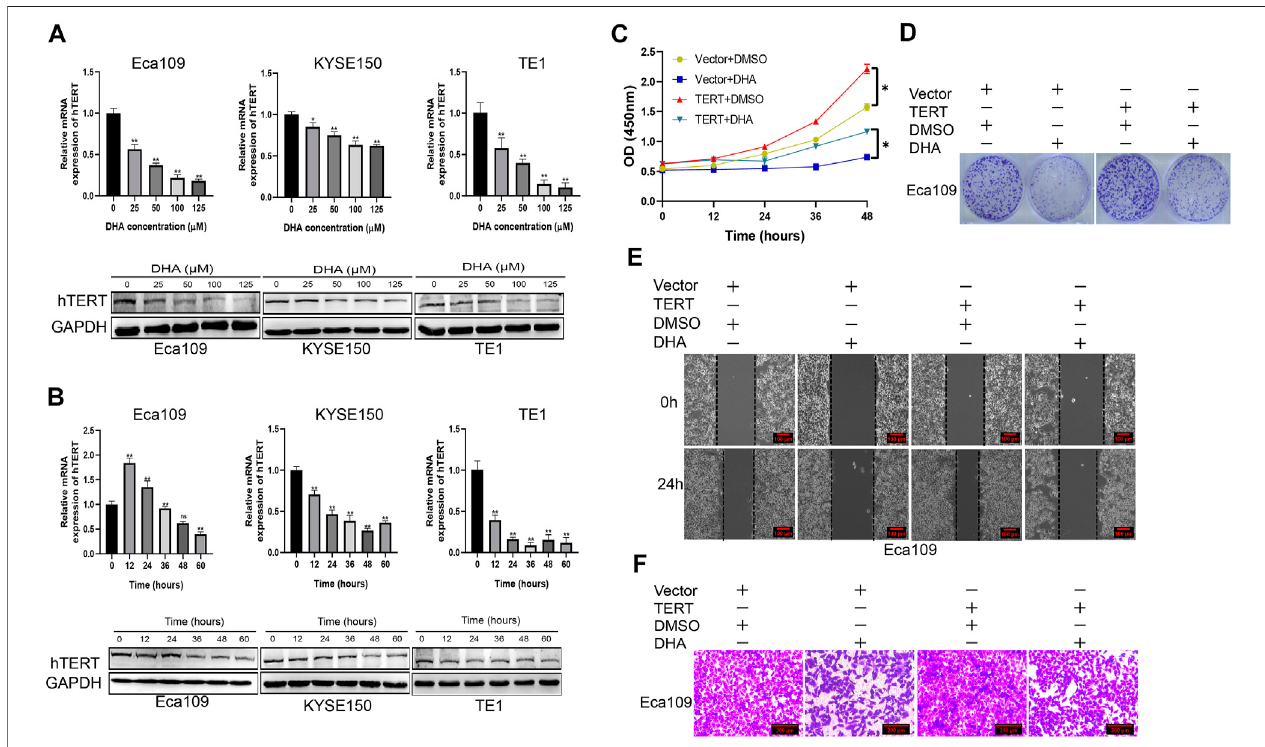
FIGURE 3 | DHA inhibits the proliferation and migration of esophageal cancer through downregulating the expression of hTERT. (A) The expression of hTERT on mRNA (upper) and protein (lower) levels in Eca09, KYSE150, and TE1 cells after treated with indicated concentration of DHA for 48 h. (B) The expression of hTERT on mRNA(upper)andprotein(lower)levelsinEca09,KYSE150,andTE1cellsaftertreatedwithDHA(100 μ M)atindicatedtimepoints. (C,D) Theeffectofoverexpressionof hTERT on the proliferation of Eca109 cells treated with DHA and evaluated by the CCK8 assay (C) and colony formation assay (D) . (E,F) Scratch assay (E) and transwell assay (F) showing in vitro migration of Eca109 cells overexpressing hTERT and treated with DHA. (* indicate p < 0.05 and ** indicate p < 0.01 compared with